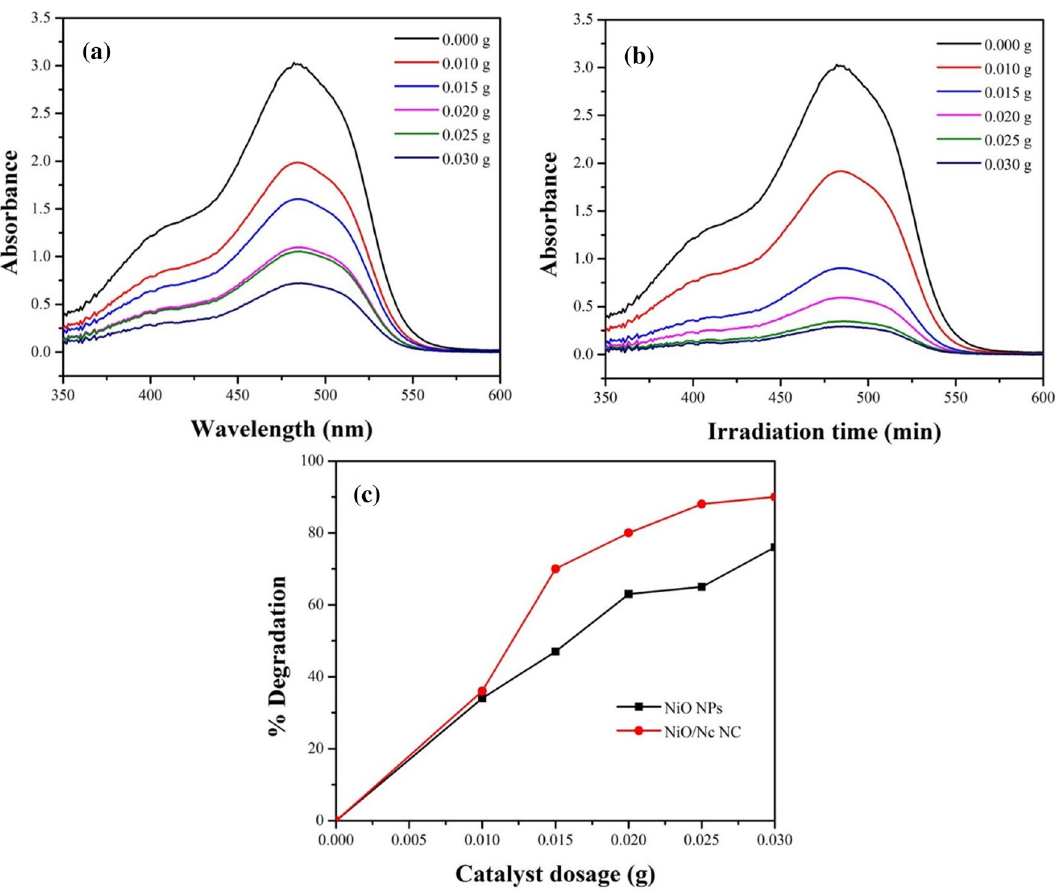
Fig. 9 UV/Vis spectra of OII dye applying different dosages of a NiO b NiO/Nc NC c %degradation of O II dye by different dosage of NiO NPs and NiO/Nc NC